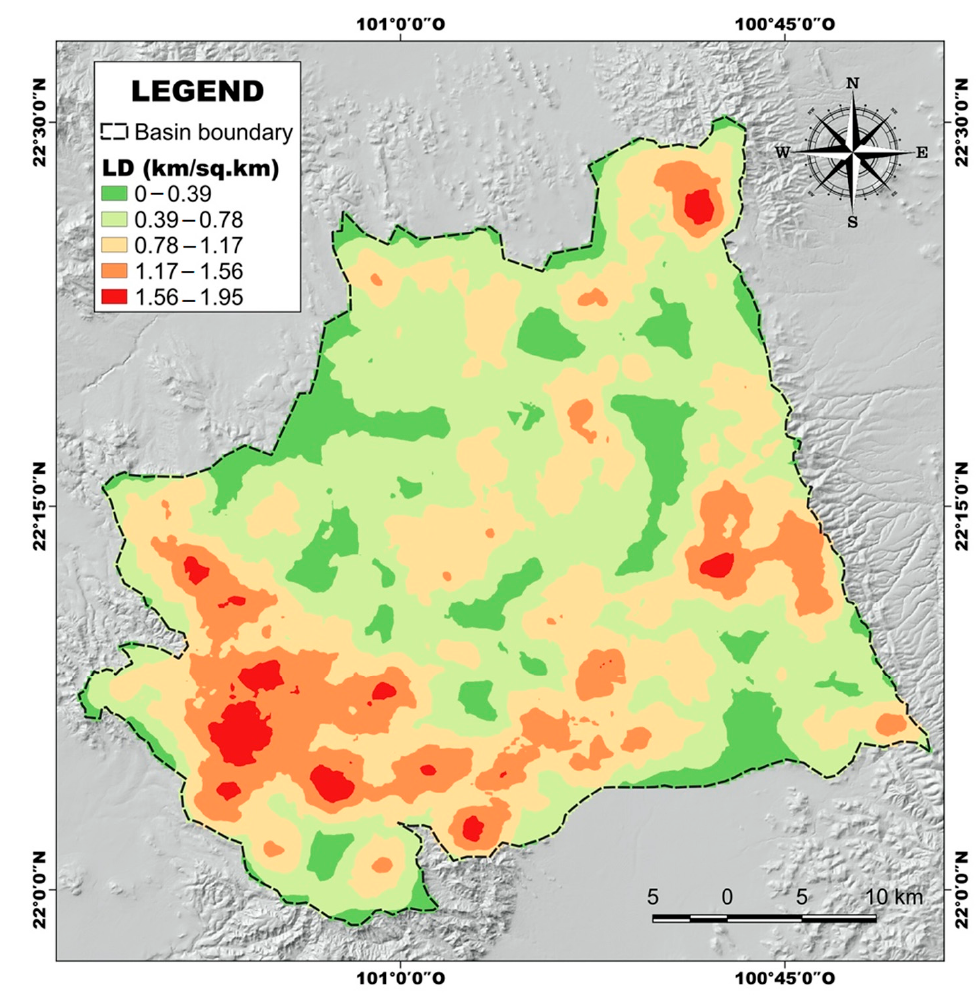
Figure 6. Lineament Density (LD) map of the San Luis Potosi Basin.